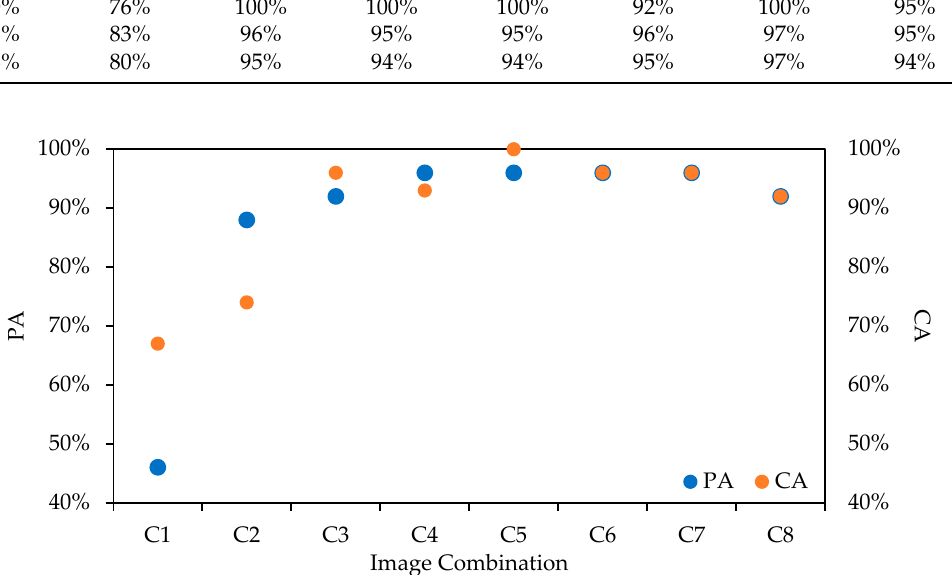
Figure 4. Producer accuracy and consumer accuracy for oil palm in 2020.